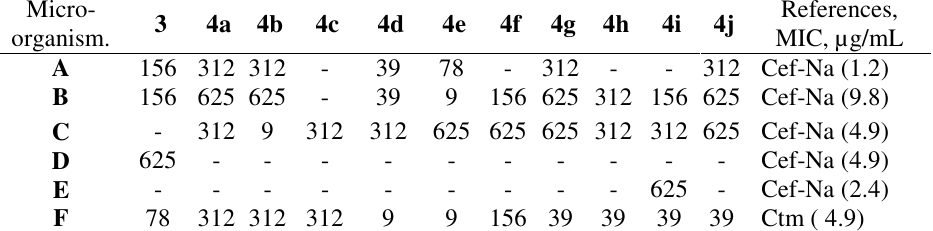
Table 2. Antimicrobial activity data of synthesized compounds a Micro-